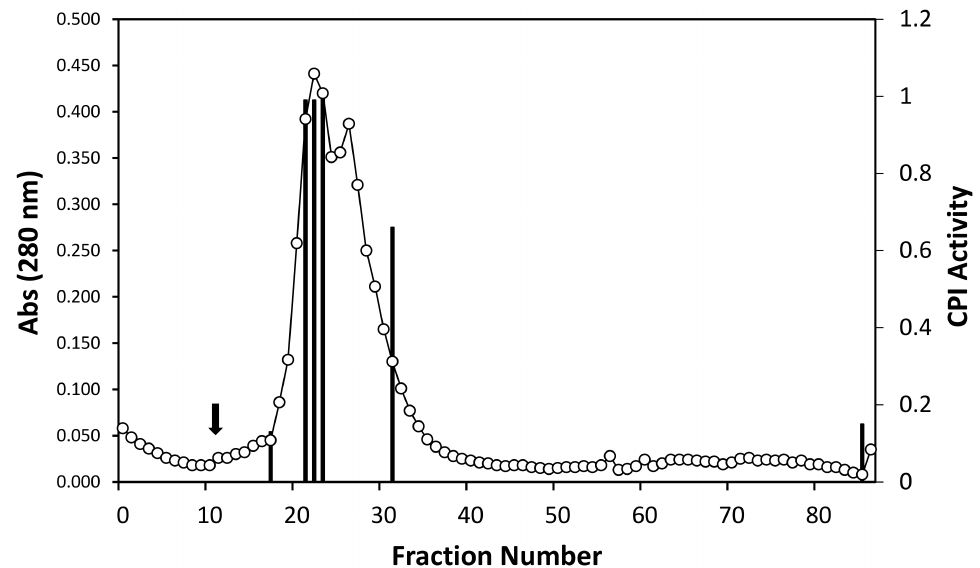
Figure 3. Elution profile from affinity chromatography on CNBr-activated papain Sepharose 4B column. Tilapia serum was applied to the column, and the column was washed to remove unbound and non-specifically bound proteins. Target protein was then eluted by adding 20 mM tri-sodium phosphate buffer (pH 10.5). Black arrow indicates the adding timing of elution buffer. Fractions were collected and screened for papain inhibitory activity (as CPI activity). Black columns show fractions with distinct CPI